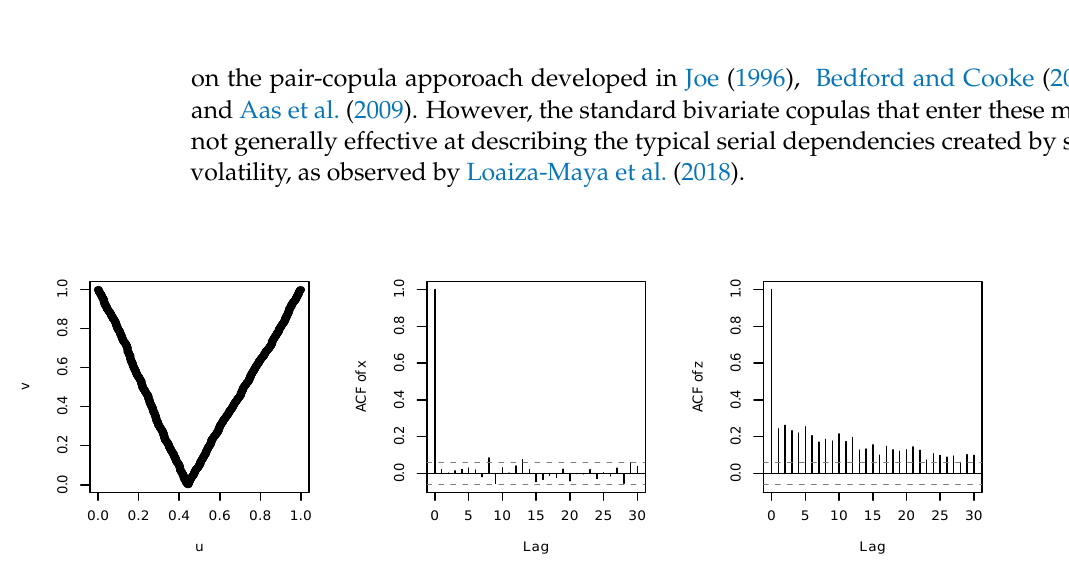
( | X | ) ( | X | ) ( | x t | ) and u t = F ( X ) ( x t ) where F ( X ) n n n and F n denote versions of the empirical